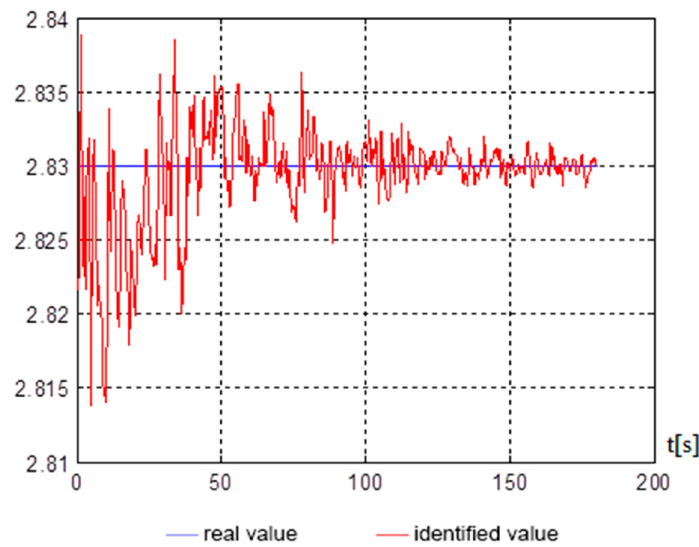
Figure 5. x T assessment over time. Figure 5. T x assessment over time.